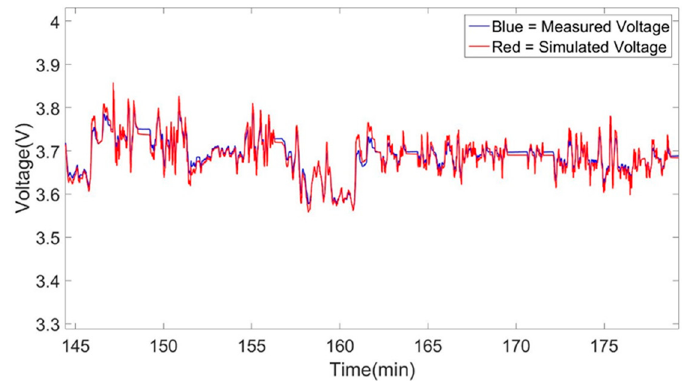
Figure 21. Dynamic behavior of the 2nd order Thévenin model measured and simulated WLTC comparison at 25 °C with Coulomb counting and advanced characterization.